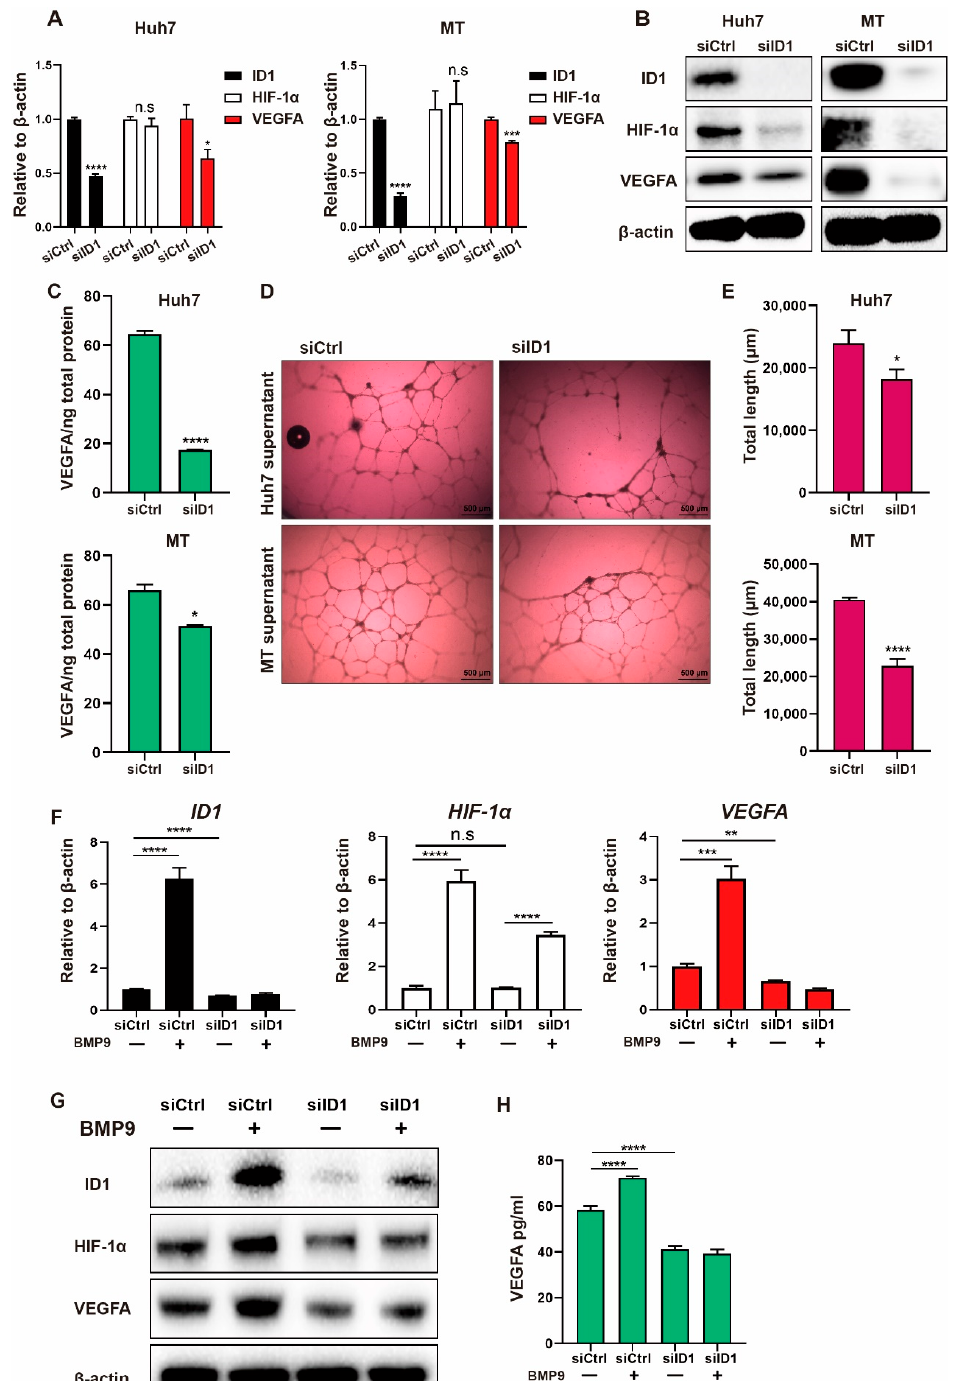
Figure 4. Inhibition of ID1 represses BMP9-induced HIF-1 α /VEGFA signaling activity in HCC cells. ( A ) Relative gene expression levels of ID1, HIF-1 α and VEGFA in Huh7 and MT cells. Cells were harvested following transfection with 20 nM control siRNA (siCtrl) or ID1 siRNA (siID1) for 48 h. ( B ) Western blot analysis of ID1, HIF-1 α and VEGFA in Huh7 and MT cells. Cells were harvested after transfection with 20 nM control siRNA (siCtrl) or ID1 siRNA (siID1) for 48 h. ( C ) ELISA analysis of VEGFA in the cell culture supernatants of Huh7 and MT cells. Cell culture supernatants were harvested following transfection with 20 nM control siRNA (siCtrl) or ID1 siRNA (siID1) for 72 h. ( D , E ) Lumen formation assay of HUVECs treated with cell culture supernatants from Huh7 and MT cells. Cell culture supernatants were harvested following transfection with 20 nM control